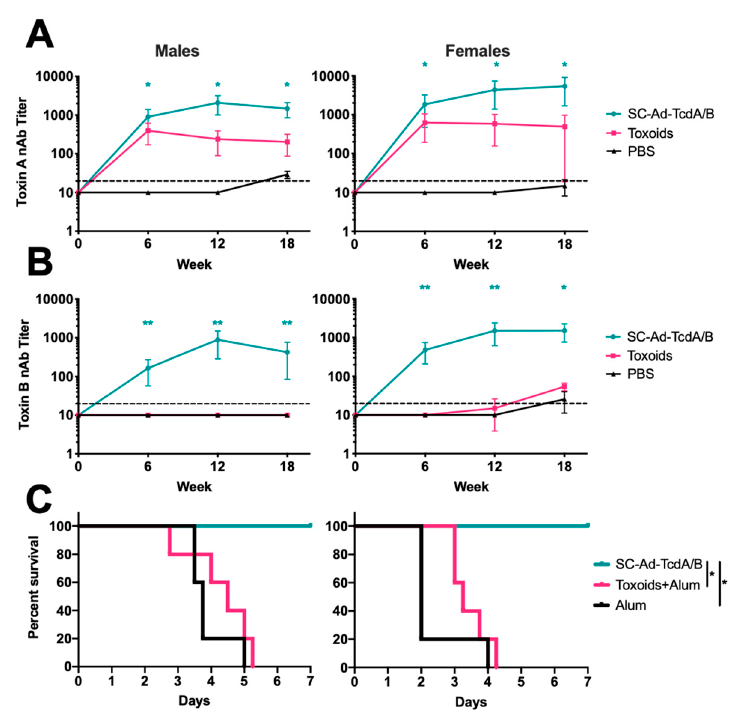
Figure 5. SC-Ad6-TcdA/B generates superior antibody and protection against lethal spore challenge compared to toxoid immunization. Male and female Syrian hamsters (n = 5) were vaccinated with SC-Ad6-TcdA/B, toxoids A and B, or Alum. Serum collected at 6, 12, and 18 weeks after immunization were assayed to determine mean neutralizing titers for ( A ) toxin A and ( B ) toxin B. In both panels, points show the mean titer, bars show standard deviation, and the dotted line indicates the limit of detection (* Adjusted p < 0.05 compared to control, ** Adjusted p < 0.05 compared to alum controls). ( C ) Survival curve for SC-Ad-TcdA/B vaccinated animals challenged with UK1 spores shows significant protection compared to toxoids A and B, and alum control animals ( p < 0.01).